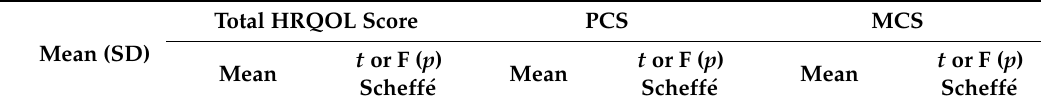
Table 1. Descriptive statistics and health-related quality of life according to general characteristics among participants ( N =